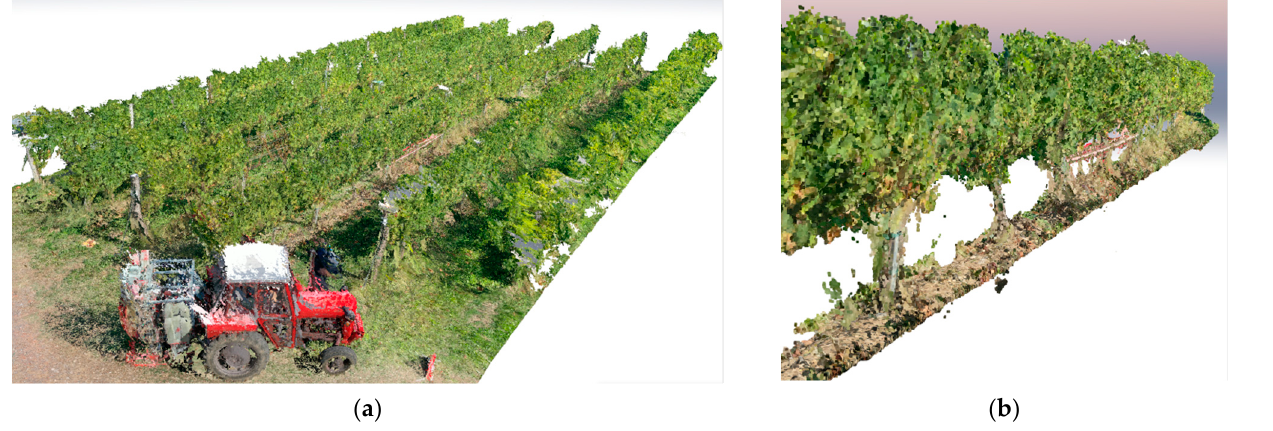
Figure 6. The UAS surveyed experimental vineyard as a point cloud from UAS photogrammetry measurements with about 195 million points ( a ), and the section used for the method comparison with about 30 million points ( b ).